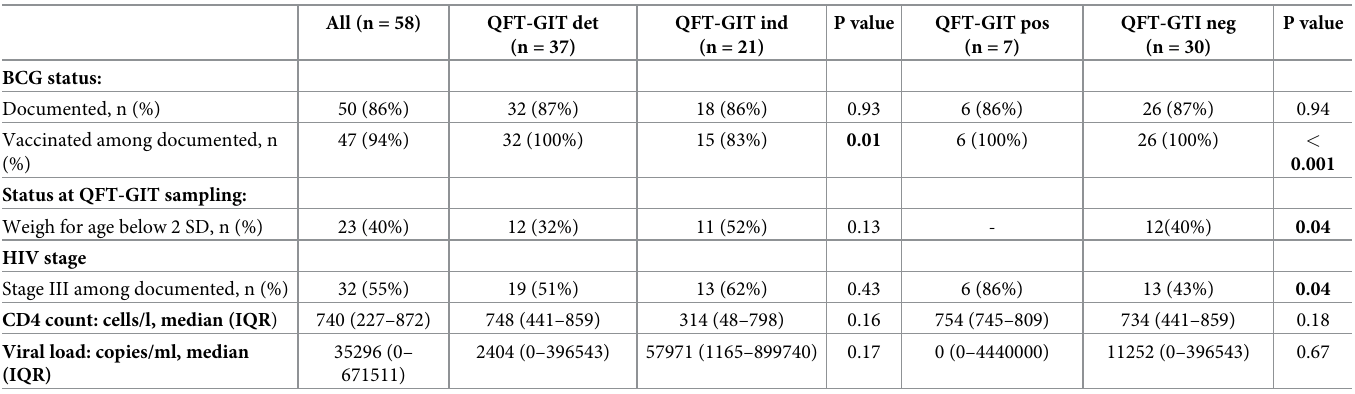
Table 4. QFT-GIT results according to BCG status, nutritional status, CD4 count and viral load.